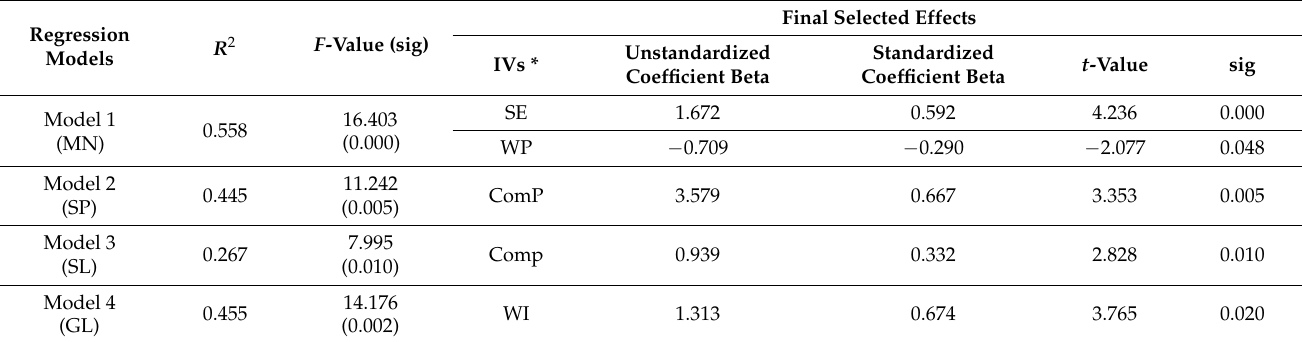
Table 4. Stepwise Regression